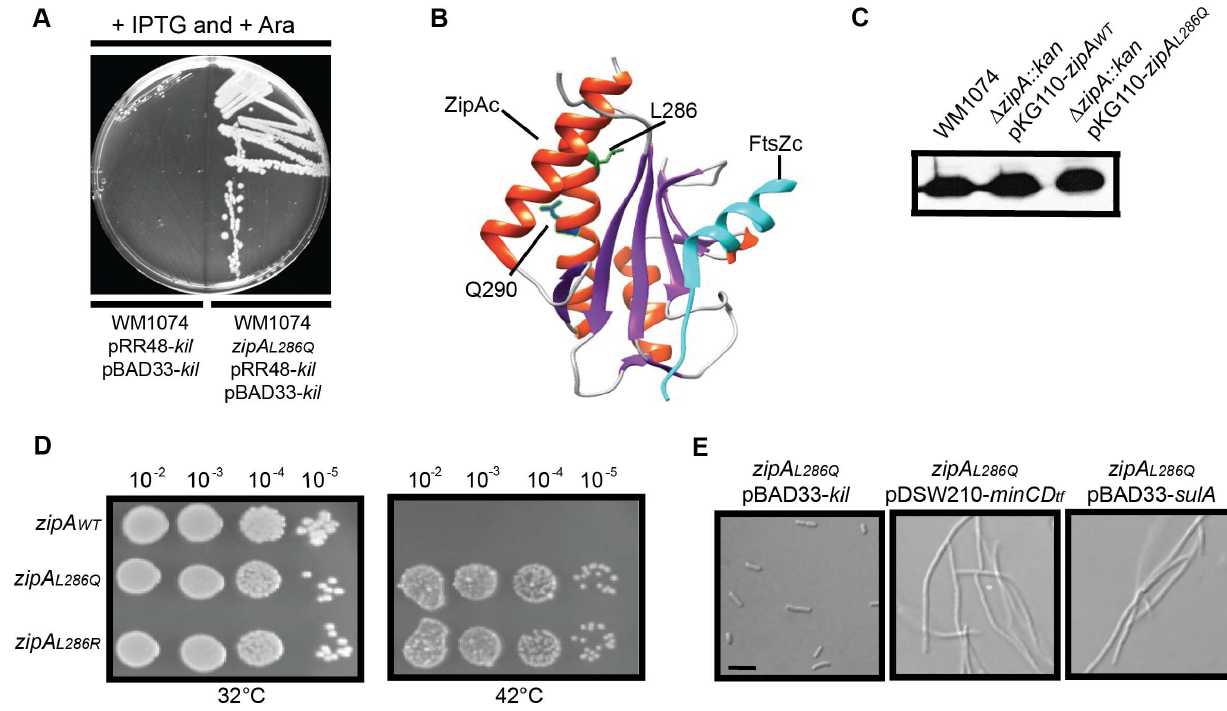
Figure 7. Isolation and characterization of Kil-resistant zipA alleles. (A) The zipA L286Q allele is a spontaneously isolated mutant resistant to loss of viability caused by kil expression from dual plasmids. Shown is an image of an LB plate with 1 mM IPTG and 0.2% arabinose to induce kil from pRR48 and pBAD33 simultaneously, with the original strain (left) and the kil -resistant isolate (right). Targeted sequencing of the zipA locus identified the resistant mutation as zipA L286Q . (B) Location of L286 and Q290 of ZipA in the co-crystal structure of the E. coli ZipA C-terminal domain (ZipA C ) with an E. coli C-terminal FtsZ peptide (FtsZ C ) [58], as generated by Chimera (http://www.cgl.ucsf.edu/chimera/). For ZipA C , a -helices are colored red and b - sheets are colored purple. The L286 sidechain is indicated in green and the Q290 sidechain in blue. FtsZ C is colored cyan. (C) ZipA WT and ZipA L286Q expressed from pKG110 are made at levels comparable to native ZipA. Shown is an immunoblot against ZipA (upper panels) from whole cell extracts of indicated strains harvested during mid-log growth in the presence of 0.5 m M sodium salicylate. (D) Replacement of the native zipA gene with zipA L286Q or zipA L286R by recombineering confers Kil resistance. Spot dilutions of indicated zipA alleles in a CC4506 background strain are shown under conditions where kil is not expressed (32 u C, left) and expressed (42 u C, right). (E) Cells harboring zipA L286Q are resistant to Kil specifically, and not to MinCD or SulA. Representative DIC micrographs of WM1074 cells with the indicated plasmids are shown under inducing conditions (0.2% arabinose for pBAD33; 1 mM IPTG for pDSW210). Scale bar=5 m